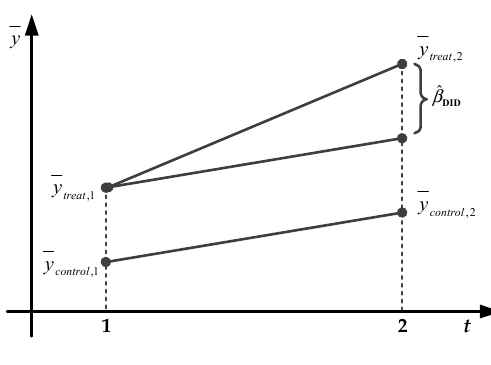
Figure 6. Schematic diagram of DID estimators.